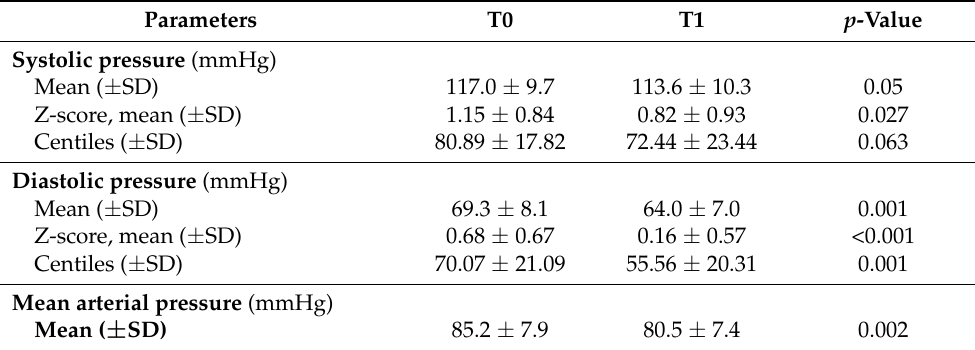
Table 2. Comparison between blood pressure measurements at baseline (T0) and after training (T1). Data are expressed as the mean ( ± standard deviation, SD). Z-scores are expressed as the mean ( ±